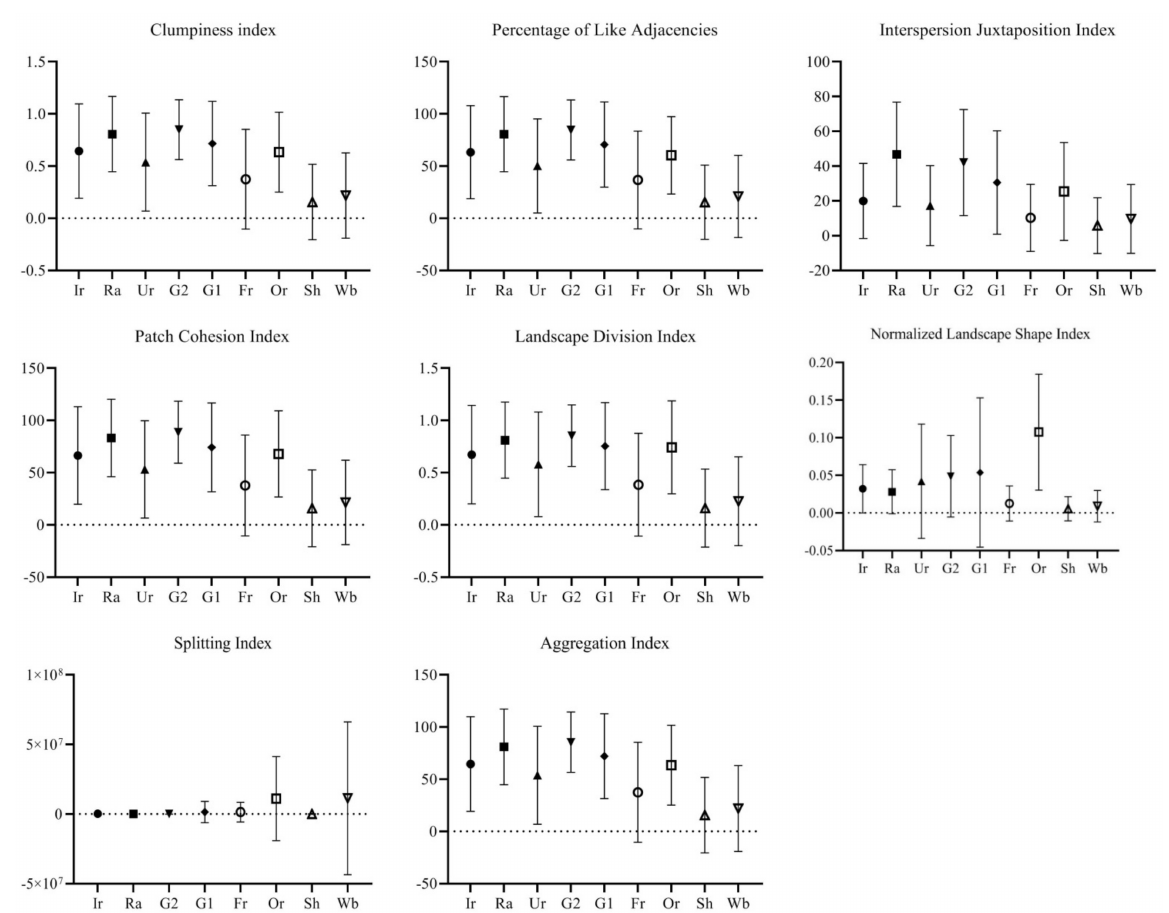
Figure 2. The box-plot of the landscape metrics of the land use/land cover types. (Ir: permanently irri- gated land, Ra: non-irrigated arable land, Ur: urban fabric area, G1: high-density grassland, G2: moderate- density grassland, Fr: broad-leaved forest, Or: permanent crops, Sh: shrubland, Wb: water